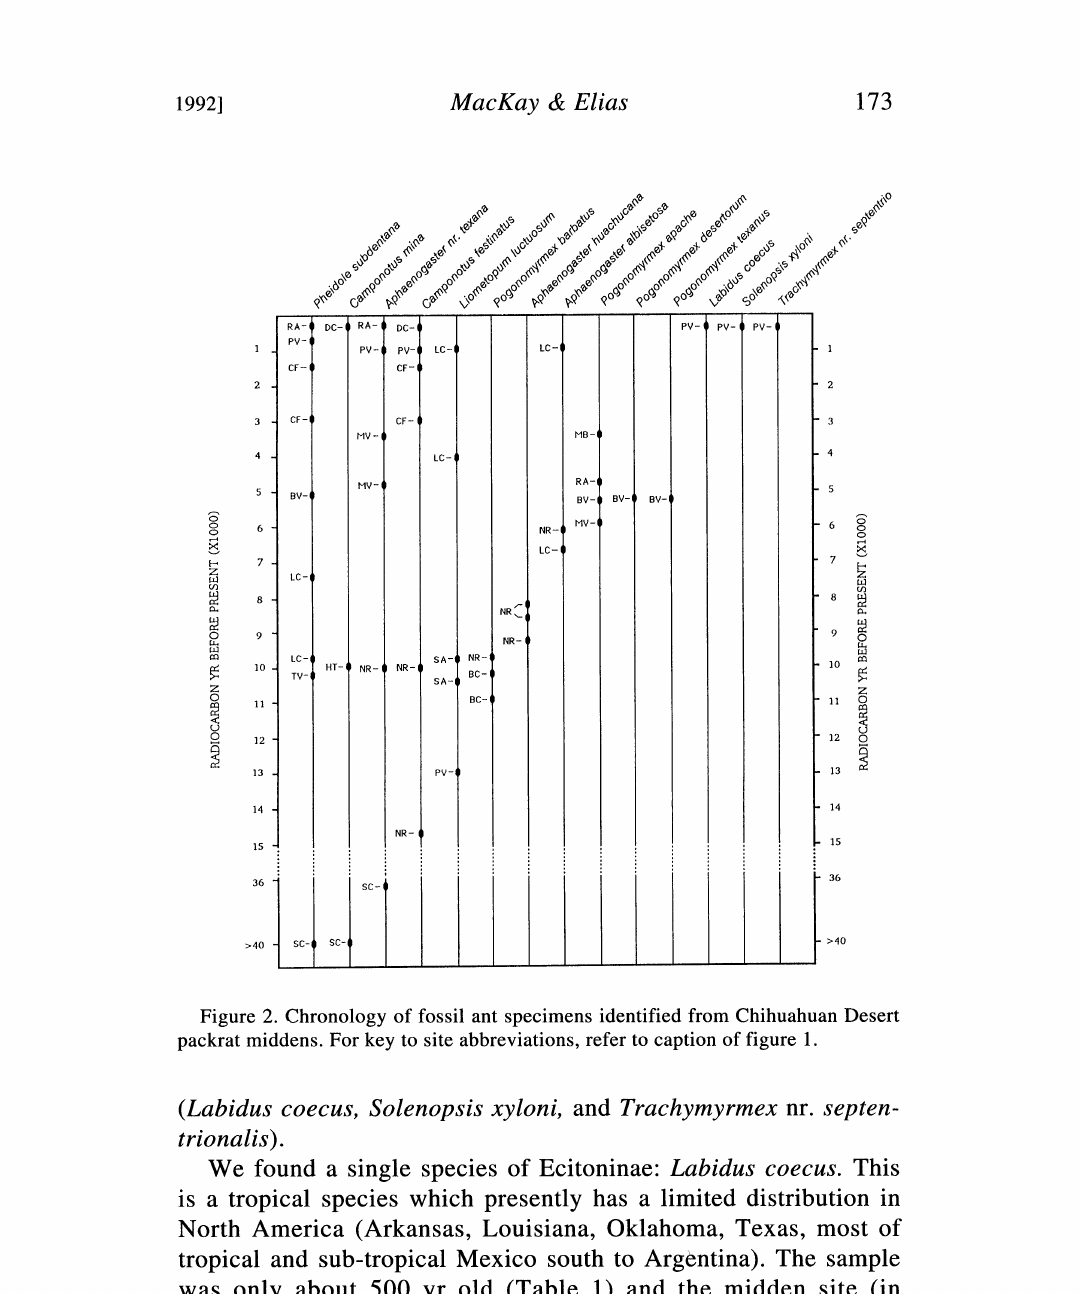
Figure 2. Chronology of fossil ant specimens identified from Chihuahuan Desert packrat middens. For key to site abbreviations, refer to caption of figure 1. (Labidus coecus, Solenopsis xyloni, and Trachymyrmex nr. septen-